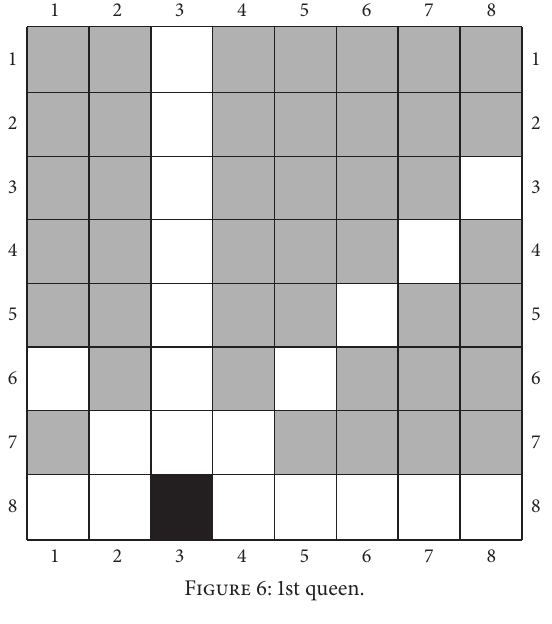
Figure 7: 2nd queen.